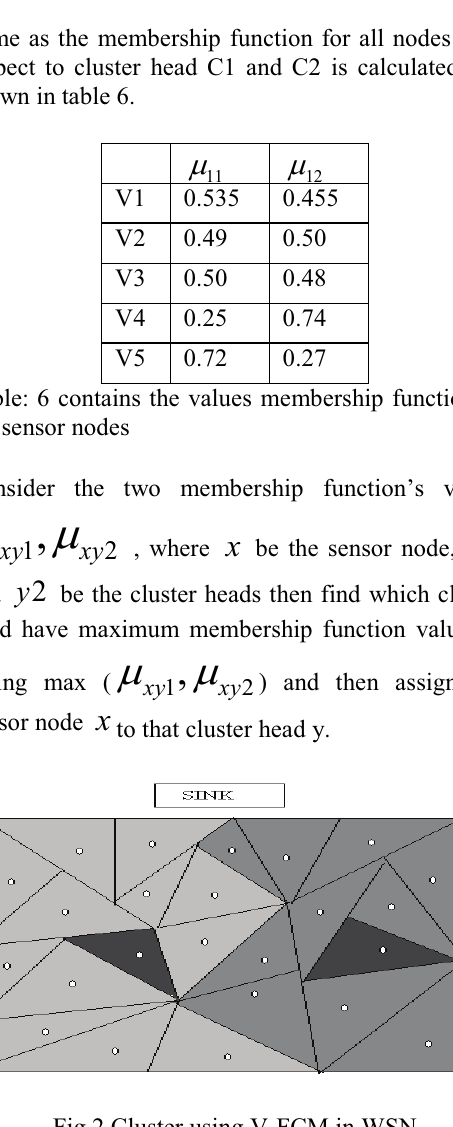
Fig 2.Cluster using V-FCM in